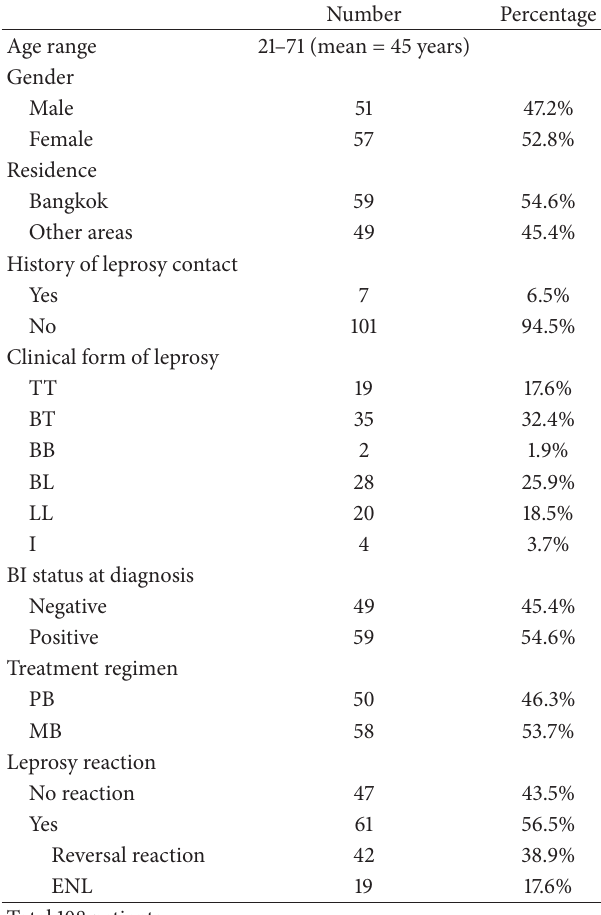
Table 1: Epidemiological characteristics and background clinical